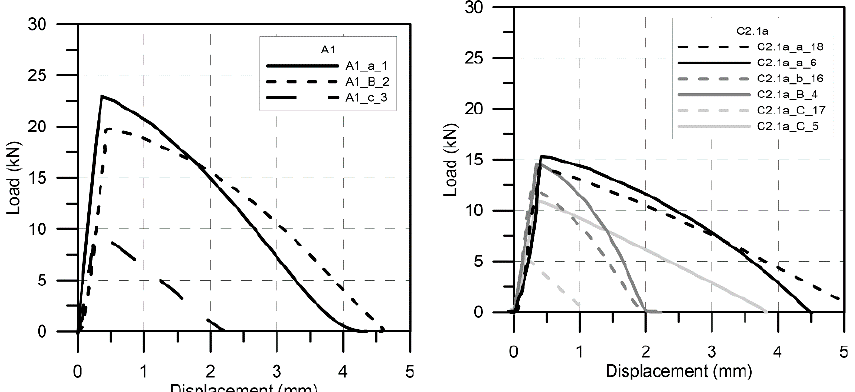
Figure 8. Tensile load vs. displacement curves.